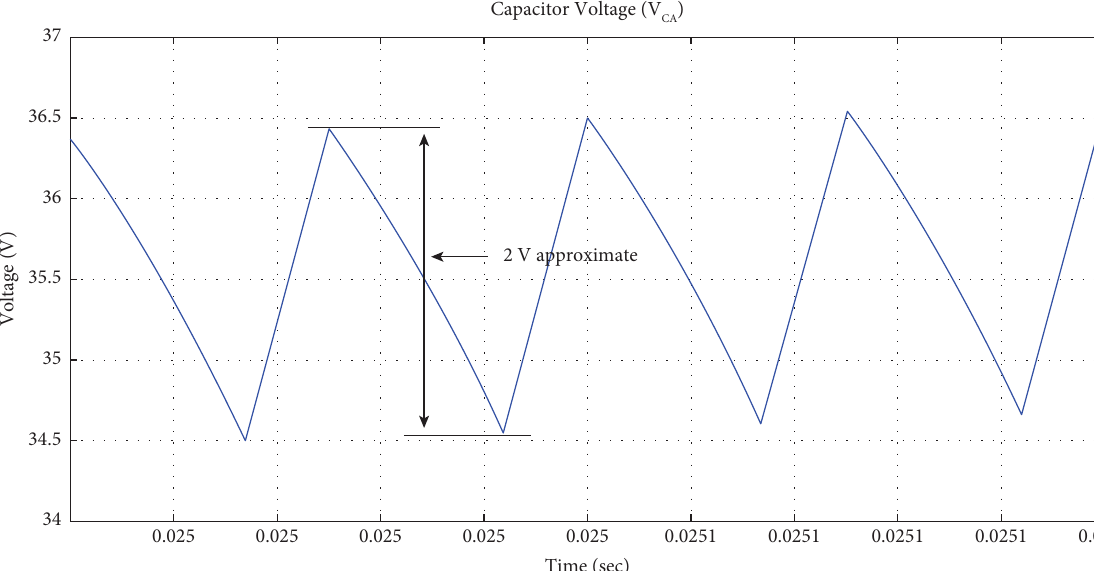
Figure 19: Te capacitor C A simulated voltage waveform.